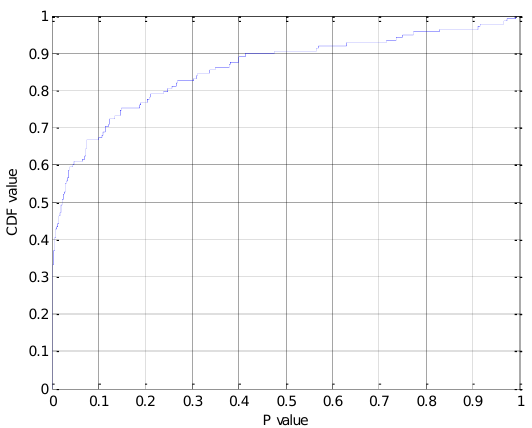
Figure 1. The P-value for the features